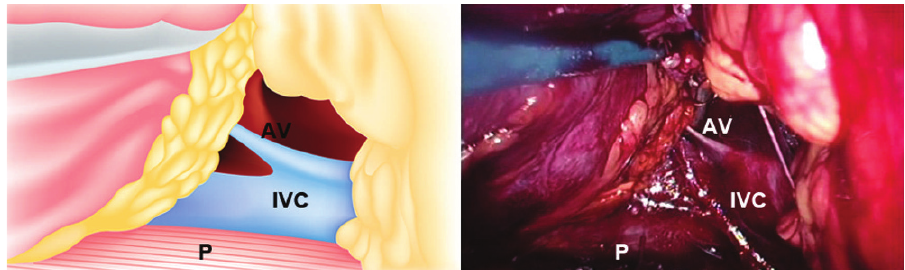
Figure 3 - Right-side retroperitoneoscopic view. AV: adrenal vein. IVC: inferior vena cava. P: psoas muscle.